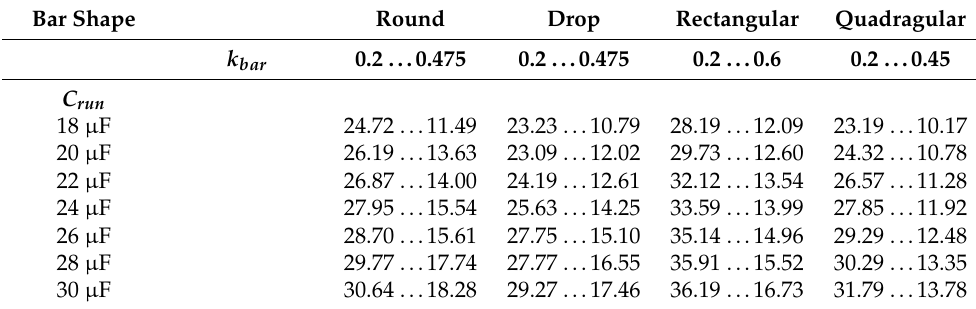
Table 13. The SPIM’s rotor ohmic losses for the minimum and maximum k bar values and indicative corresponding C run values, for rotor bars of round, drop, rectangular and quadrangular